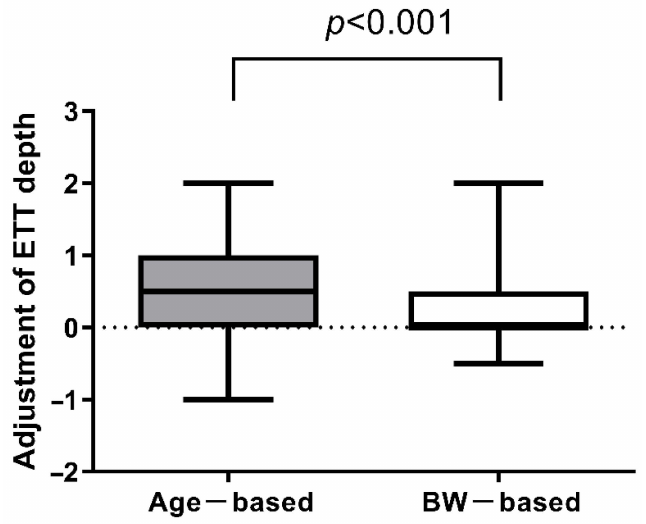
Figure 3. The adjusted depth for age-based and weight-based recommendations in group 2. Data are median (interquartile range). ETT: endotracheal tube; BW: body weight.